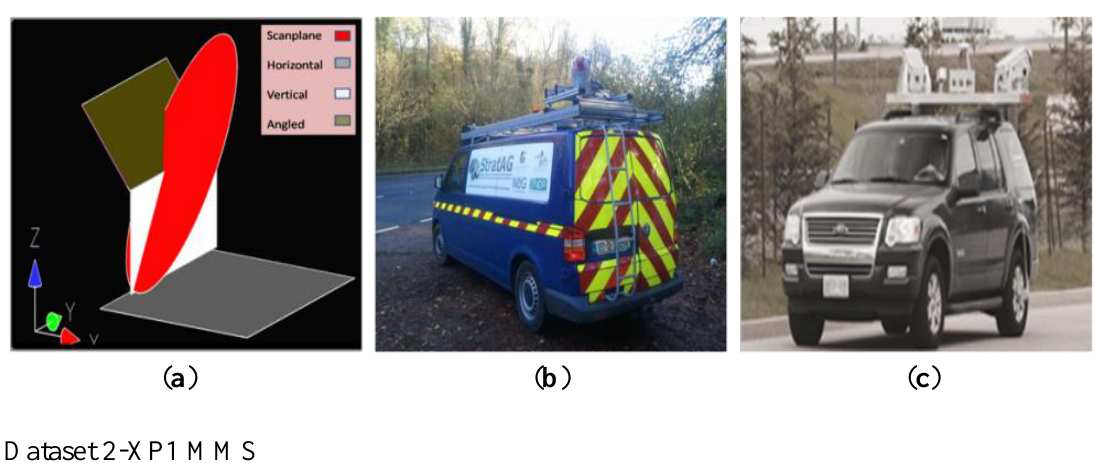
Figure 6. Validation ( a ) initial tests with constructed CAD models ( b ) survey data captured by the XP1 ( c ) survey data captured by the Optech Lynx